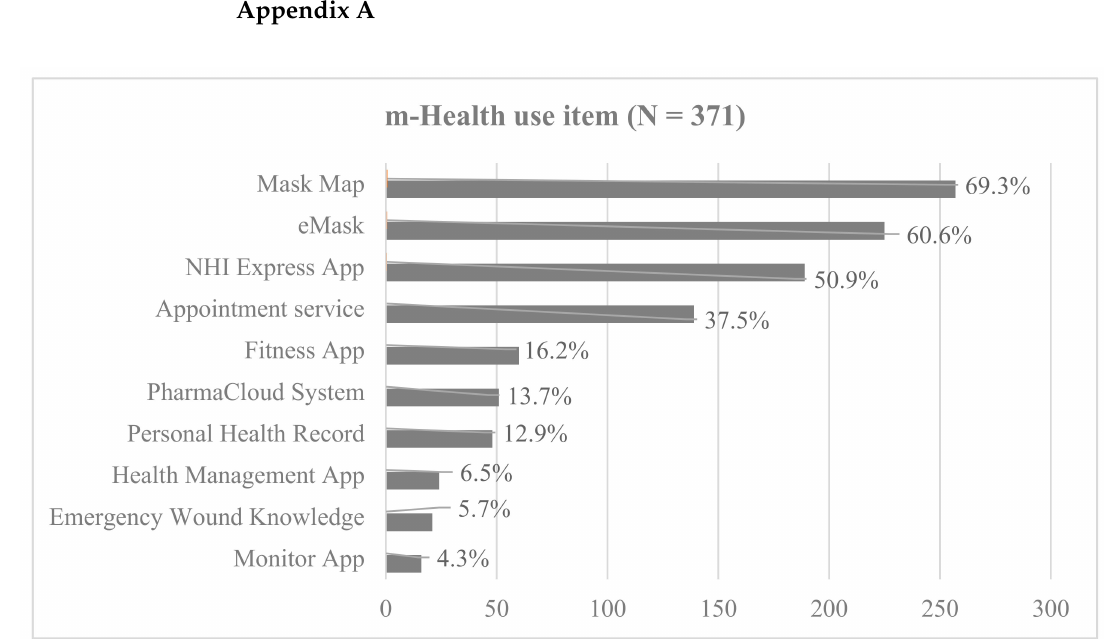
Figure A1. m-Health services used in Taiwan.